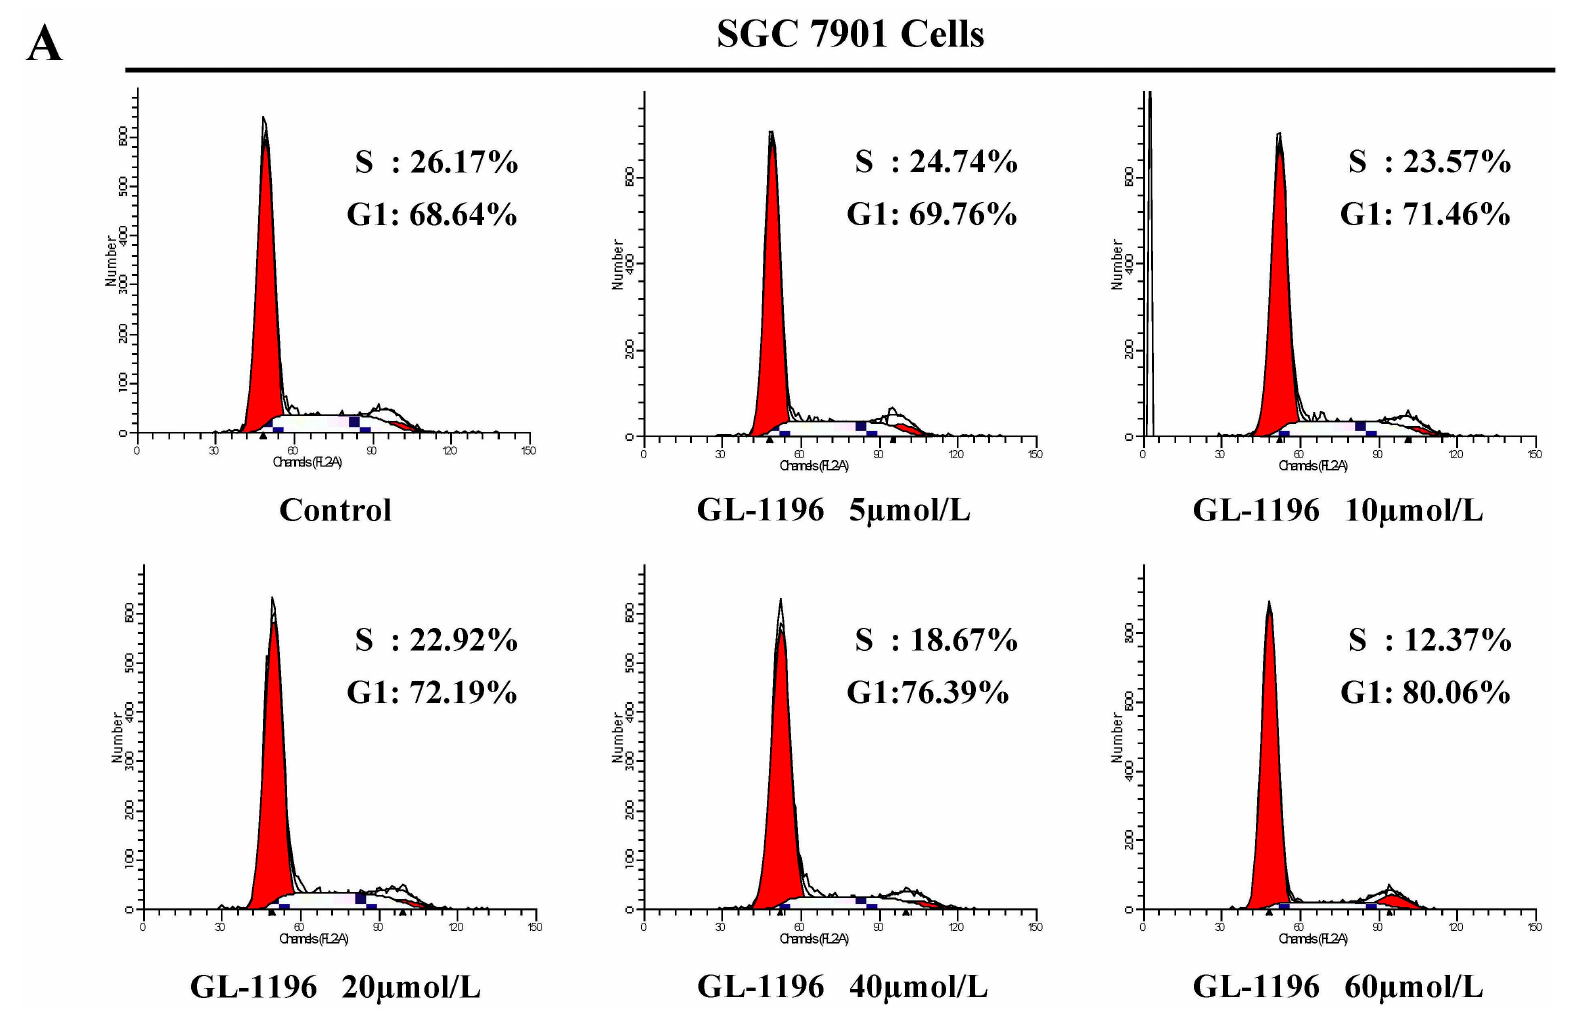
Figure 2. Figure 2. Cont.